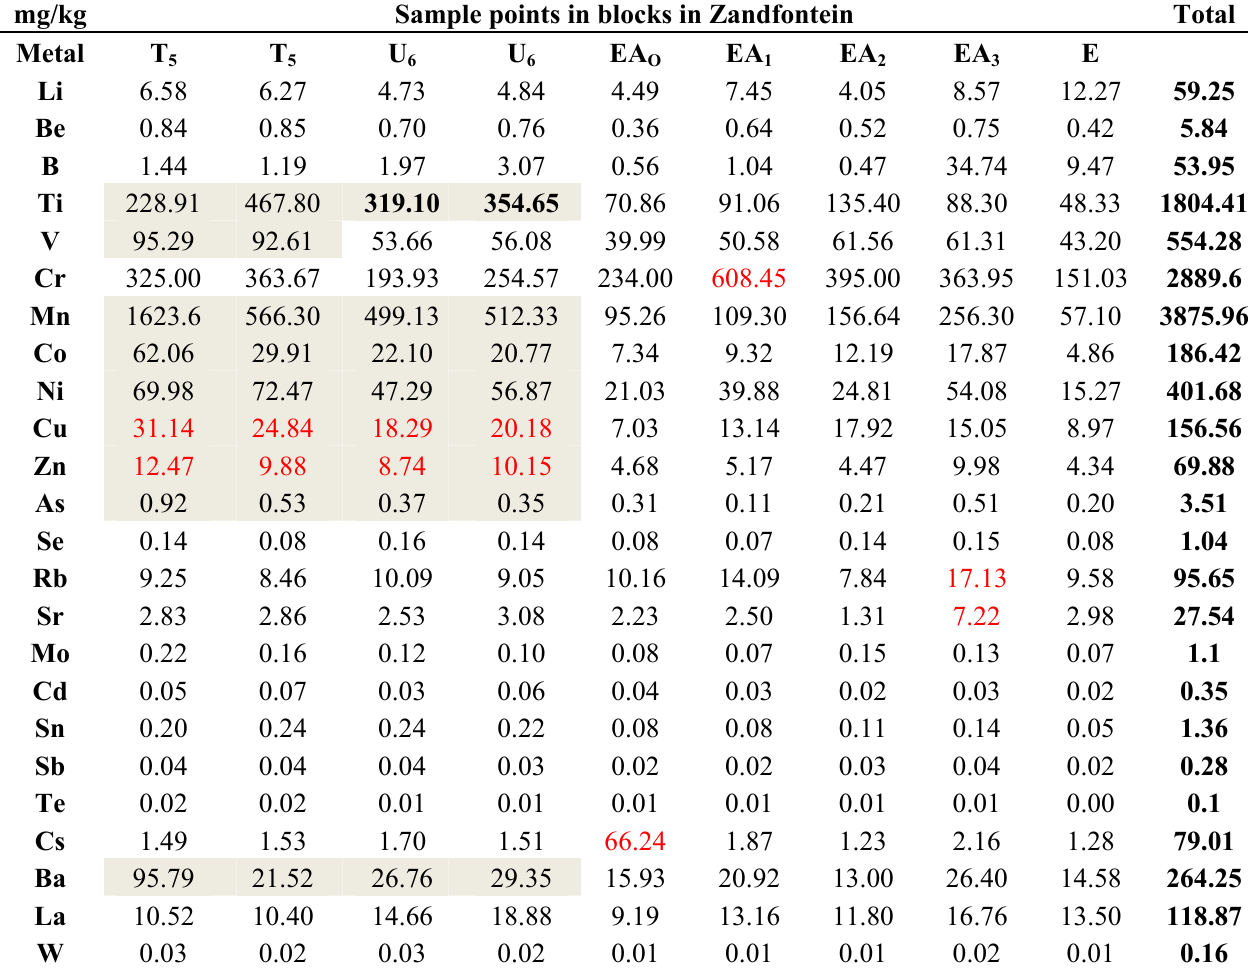
Table 3. Mean soils mineral concentrations in various blocks of Zandfontein Cemetery (mg/kg). mg/kg Sample points in blocks in